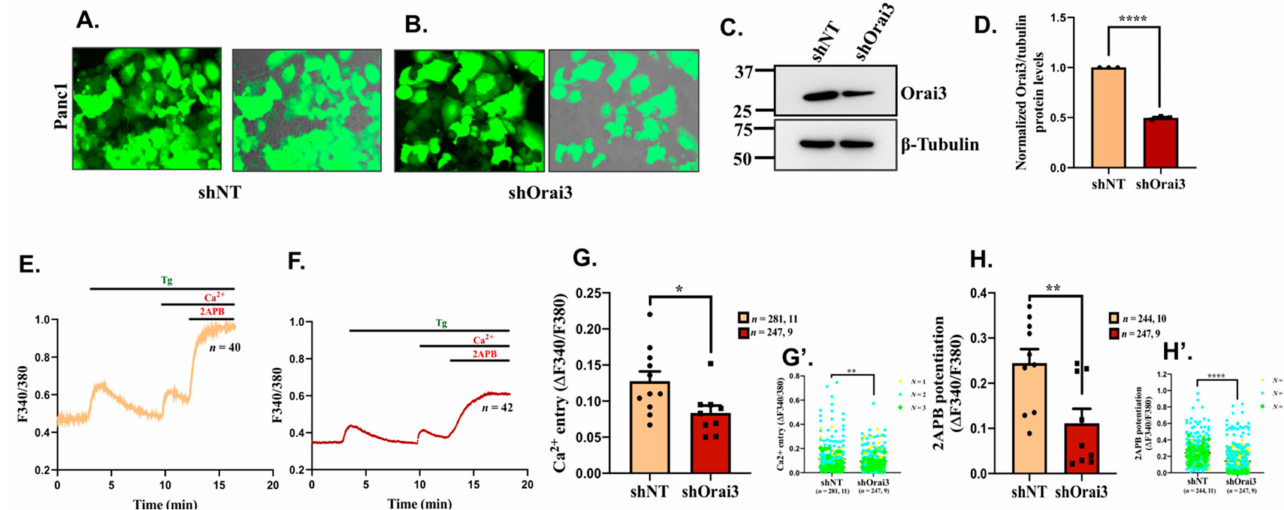
Figure 3. Orai3 encodes a functional SOCE channel in Panc1 cells. ( A , B ) Lentiviral transduced Panc1 cells stably expressing either GFP tagged shNT control or GFP tagged shRNA targeting Orai3 (fluorescence and merged images of bright field plus fluorescence are presented). ( C ) Representative Western blot showing knockdown of Orai3 in shOrai3 Panc1 stables in comparison to shNT control Panc1 stable cells. ( D ) Densitometric analysis of Orai3 silencing in 3 independent shNT and shOrai3 Panc1 stable clones. ( E ) Representative Ca 2+ imaging trace of shNT Panc1 stables where “ n = 40” denotes the number of cells in that particular trace. ( F ) Representative Ca 2+ imaging trace of shOrai3 Panc1 stables where “ n = 42” denotes the number of cells imaged in that particular trace. ( G ) The extent of SOCE was calculated from 281 shNT and 247 shOrai3 cells, which were imaged from several autonomous experiments/traces (11 traces of shNT and 9 traces of shOrai3 originating from 3 independent clones of shNT and shOrai3 Panc1 stables) and data from autonomous traces are presented in dot plot graphs. ( G’ ) Data for extent of SOCE from all individual cells from 3 independent clones are presented as clone N ◦ 1 yellow rounds, clone N ◦ 2 blue squares, clone N ◦ 3 green diamond. ( H ) 2-APB induced potentiation of Orai3 mediated SOCE was calculated from around 250 cells/condition. These cells were imaged during several autonomous experiments/traces (10 traces of shNT and 9 traces of shOrai3 originating from 3 independent clones of shNT and shOrai3 Panc1 stables) and data are presented in dot plot graphs. ( H’ ) Data for 2-APB induced SOCE potentiation from all individual cells from 3 independent clones are presented as clone N ◦ 1 yellow rounds, clone N ◦ 2 blue squares, clone N ◦ 3 green diamond. The total number of cells imaged are reported in ( G , H ) as “ n = x, y” where “x” denotes total number of cells imaged and “y” denotes number of traces recorded. Data presented are mean ± S.E.M. Unpaired Student’s t -test was performed for statistical analysis. p -value < 0.05 was considered as significant and is presented as “*”; p -value < 0.01 is presented as “**”and p -value < 0.0001 is presented as